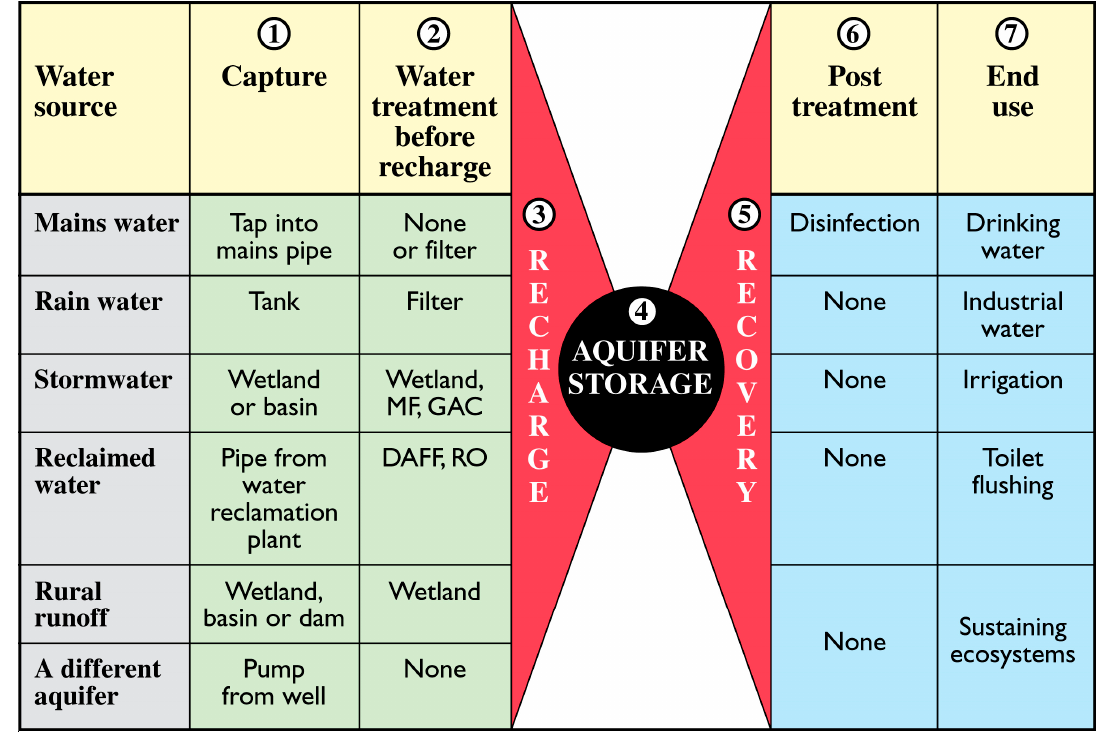
Figure 2. Examples of potential configurations of urban MAR systems (after Natural Resource Management Ministerial Council-Environment Protection and Heritage Council-National Health and Medical Research Council. 2009 [14]), MF—Micro Filtration, GAC—Granular Activated Carbon, DAFF—Dissolved Air Floatation Flocculation, RO—Reverse Osmosis.